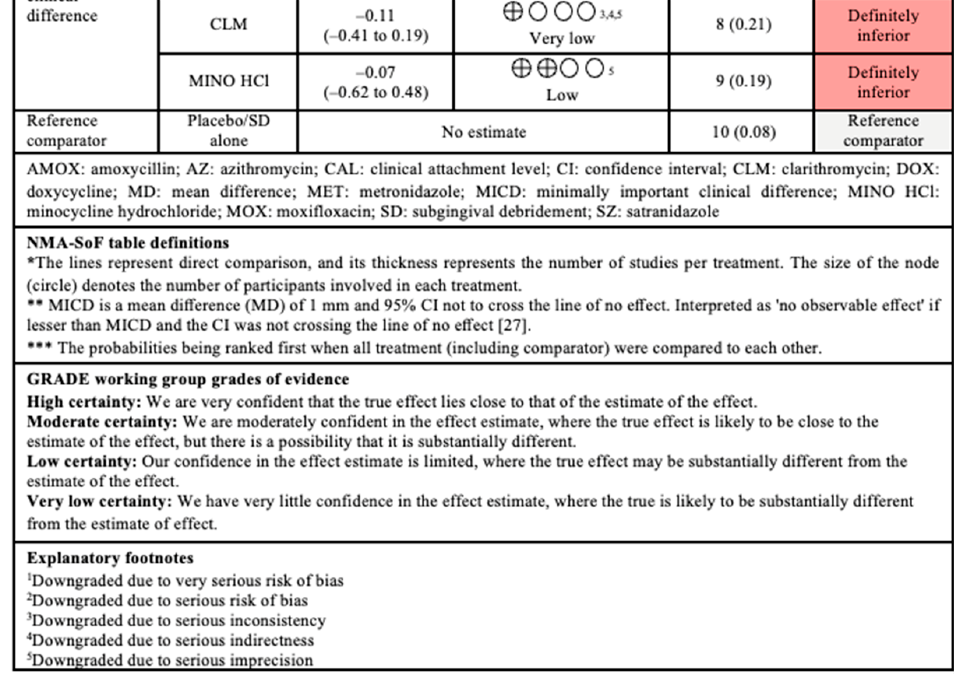
Figure 7. Summary of findings for intermediate-term CAL gain following the use of systemic antibiotics adjunctive to subgingival debridement.